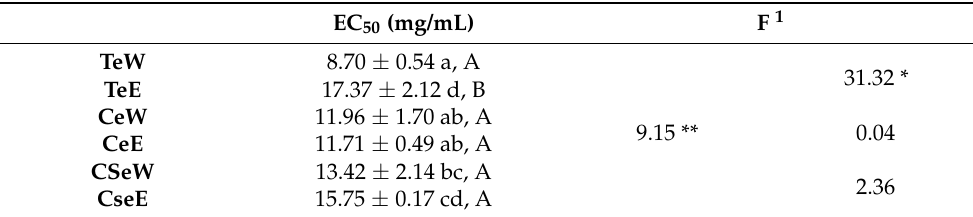
Table 2. Toxicity results from Microtox ® assay of vine − shoot extracts as EC 50 (mg/mL) after 15 min incubation